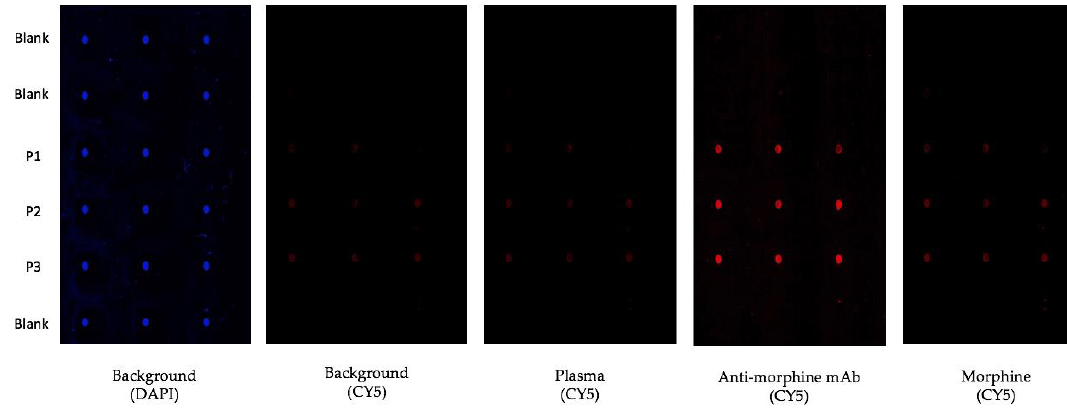
Figure 9. Testing the illuminating peptide sensor chip for morphine detection, after 20 min of incubation. The background picture was taken in PBS. Plasma picture was taken in 10% human blood plasma in PBS. Anti-morphine mAb concentration was 3.5 nM and morphine concentration was 0.35 µM. Rows number 1, 2, and 6 are blank spots without illuminating peptides.